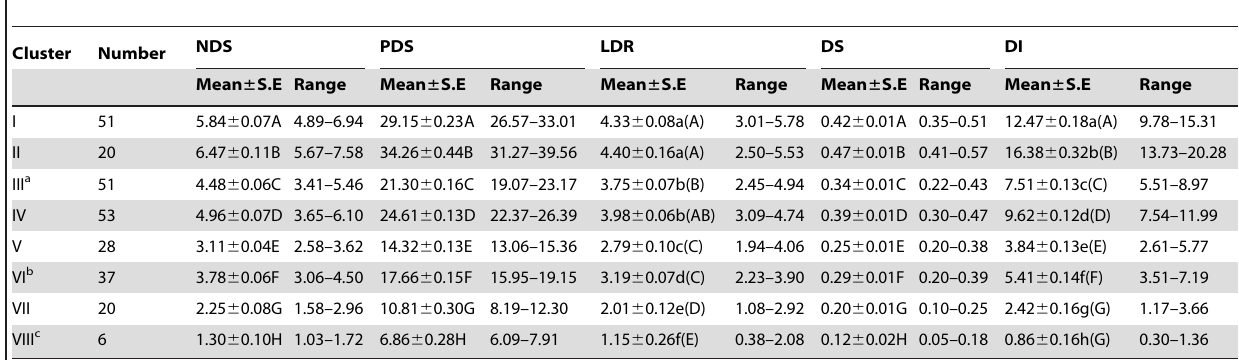
Table 3. Comparisons of eight groups based on hierarchical clustering using five FHB-related traits.